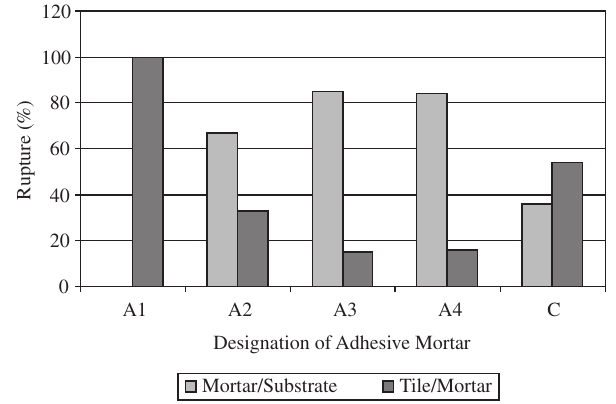
Figure 2. Rupture (%) resulting from the tensile bond strength test.